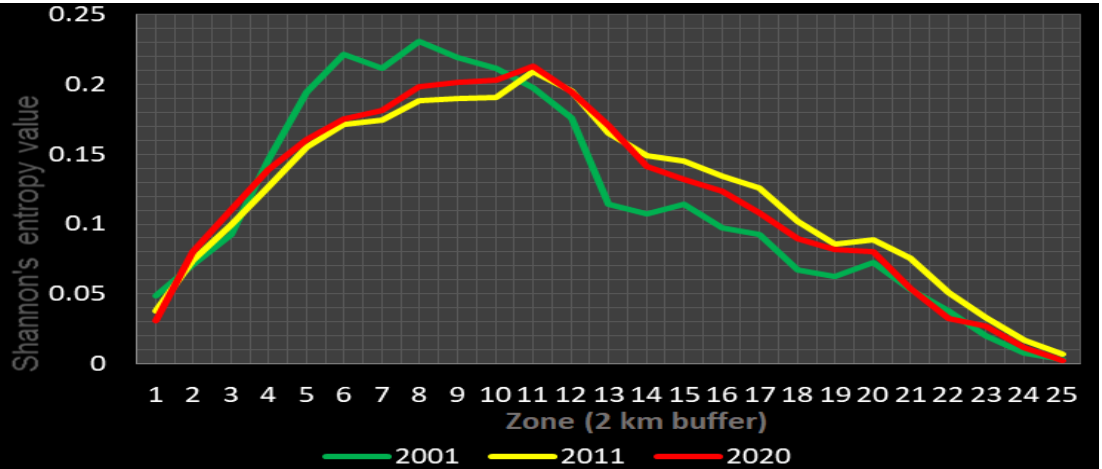
Figure 9. Zone wise value of Shannon's entropy in Bengaluru for the years 2001, 2010 and 2020.